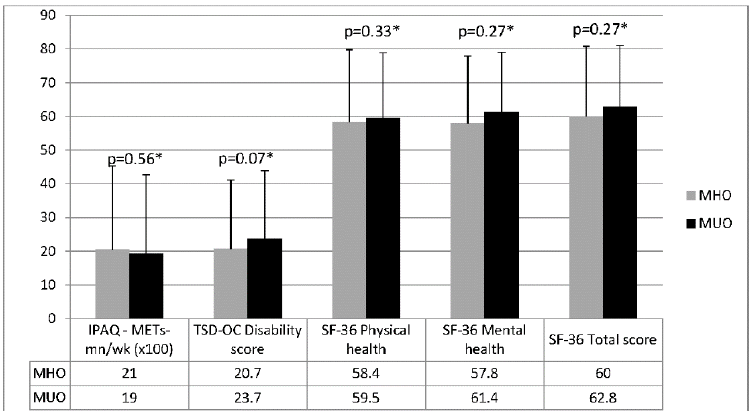
Figure 1. Physical activity level, disability, and health-related quality of life parameters in metabolically healthy obese (MHO) and metabolically unhealthy obese (MUO) subjects. Legend: IPAQ: International Physical Activity Questionnaire; TSD-OC: Test SIO for obesity-related disability: SF-36: Short-Form-36 questionnaire for health-related quality of life; * after adjustment for age, gender, and BMI.